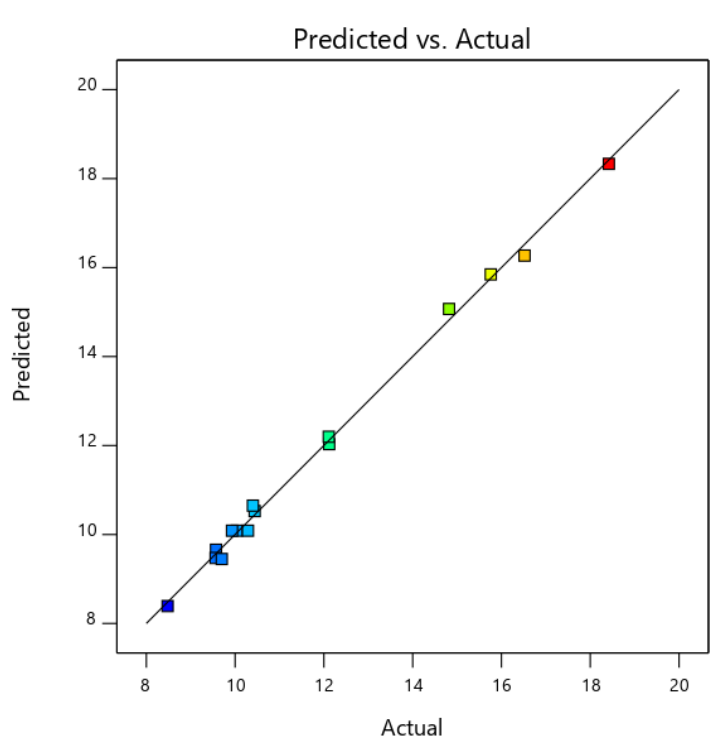
Figure 5. Comparison of actual and predicted results of CO 2 absorption.